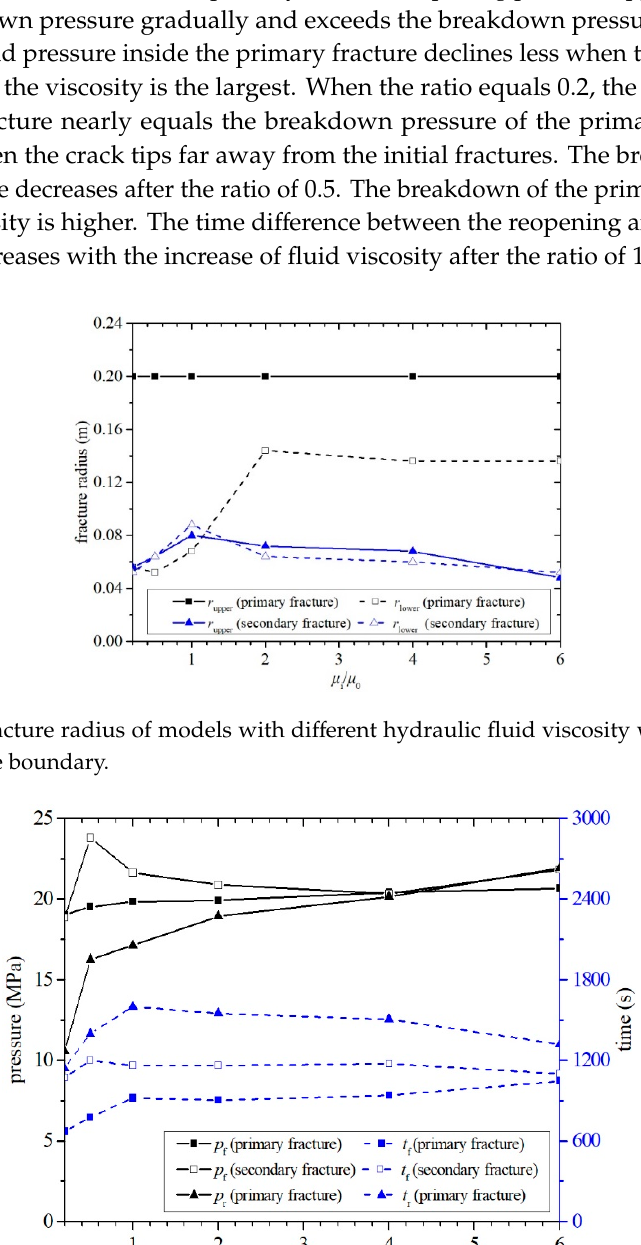
Figure 21. The breakdown pressure/time and reopening pressure/time of fractures in models with different viscosity to summarize, the RFPA-Petrol was used to investigate the influence of the hydraulic fracturing fluid properties on the propagation of dual hydraulic fractures in a multilayered laboratory-scale model. It is found that fracturing fluid properties play a key role in whether dual fractures can cross the barrier. When the low viscosity fluid is used, or the injection flux is small, the dual fractures cannot cross the barrier and the secondary fracture may merge into the primary fracture. If high viscosity fluid is used or injection flux is large, the primary fracture penetrates the barrier and branches off above the barrier. The secondary fracture is influenced by both the fluid properties and the primary fracture, so the injection should control properly to make sure that both of the dual fractures penetrate the barrier.